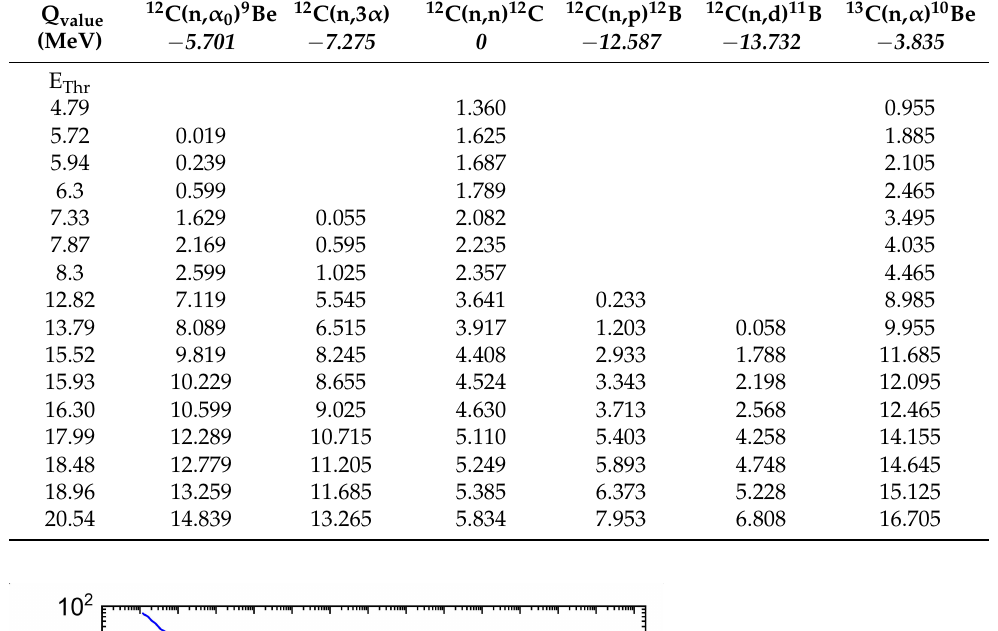
Table 4. n-Carbon reactions for neutron energy up to 20 MeV. Each column reports the total kinetic energy E T (in MeV) of the reaction products as function of the threshold energy (E Thr ) which is reported in the first column. E T corresponds to the total amount of energy deposited in the diamond bulk. The Q-value of the various reaction is also reported (in italic).